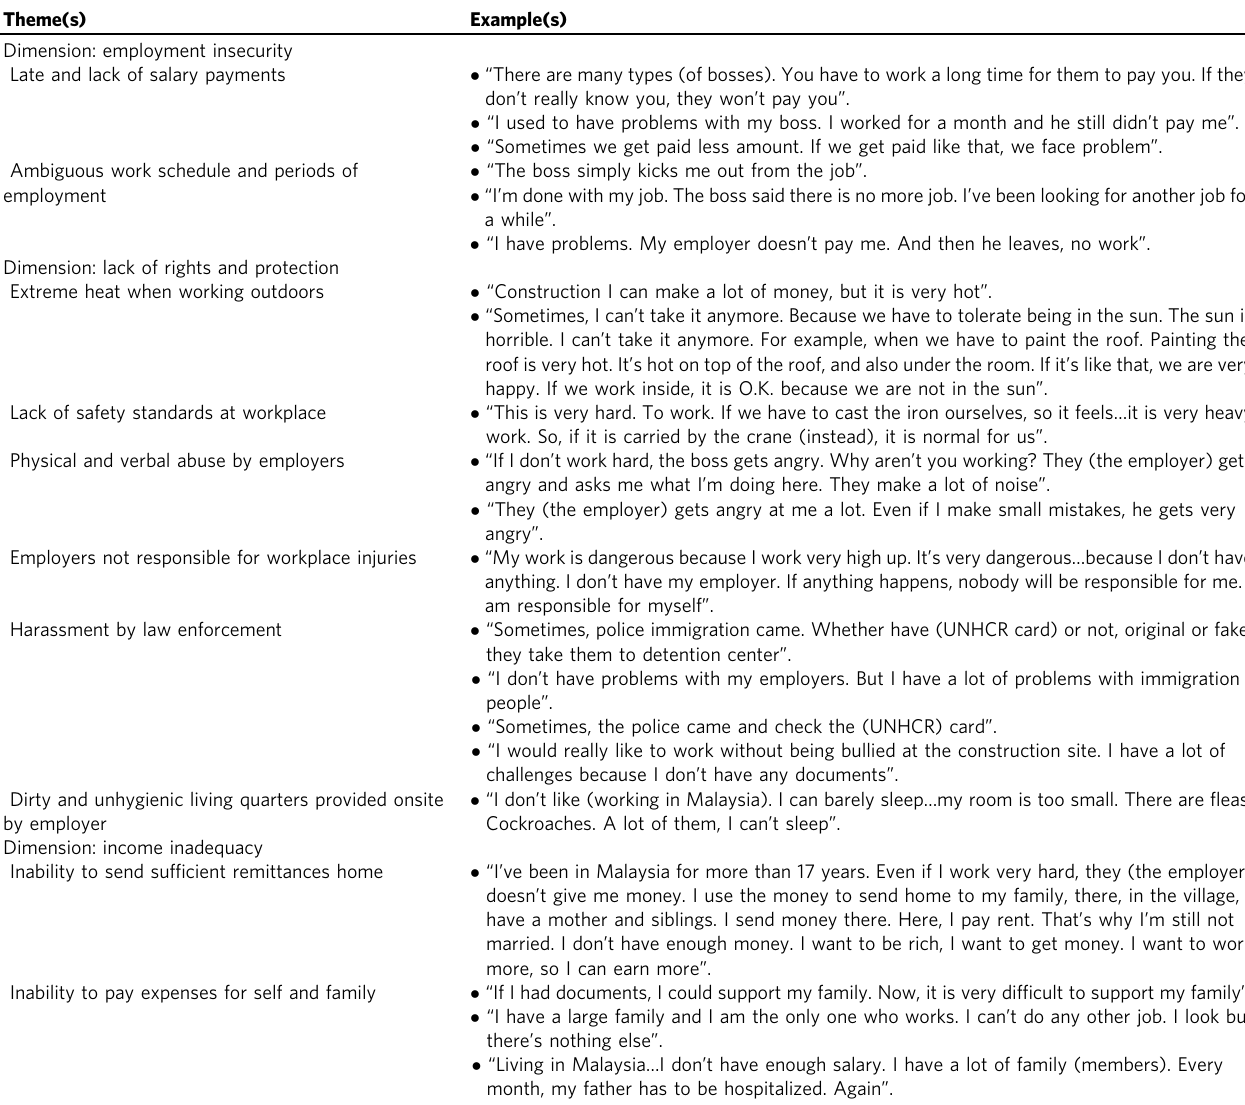
Table 5 Dimensions and themes surrounding precarious employment.